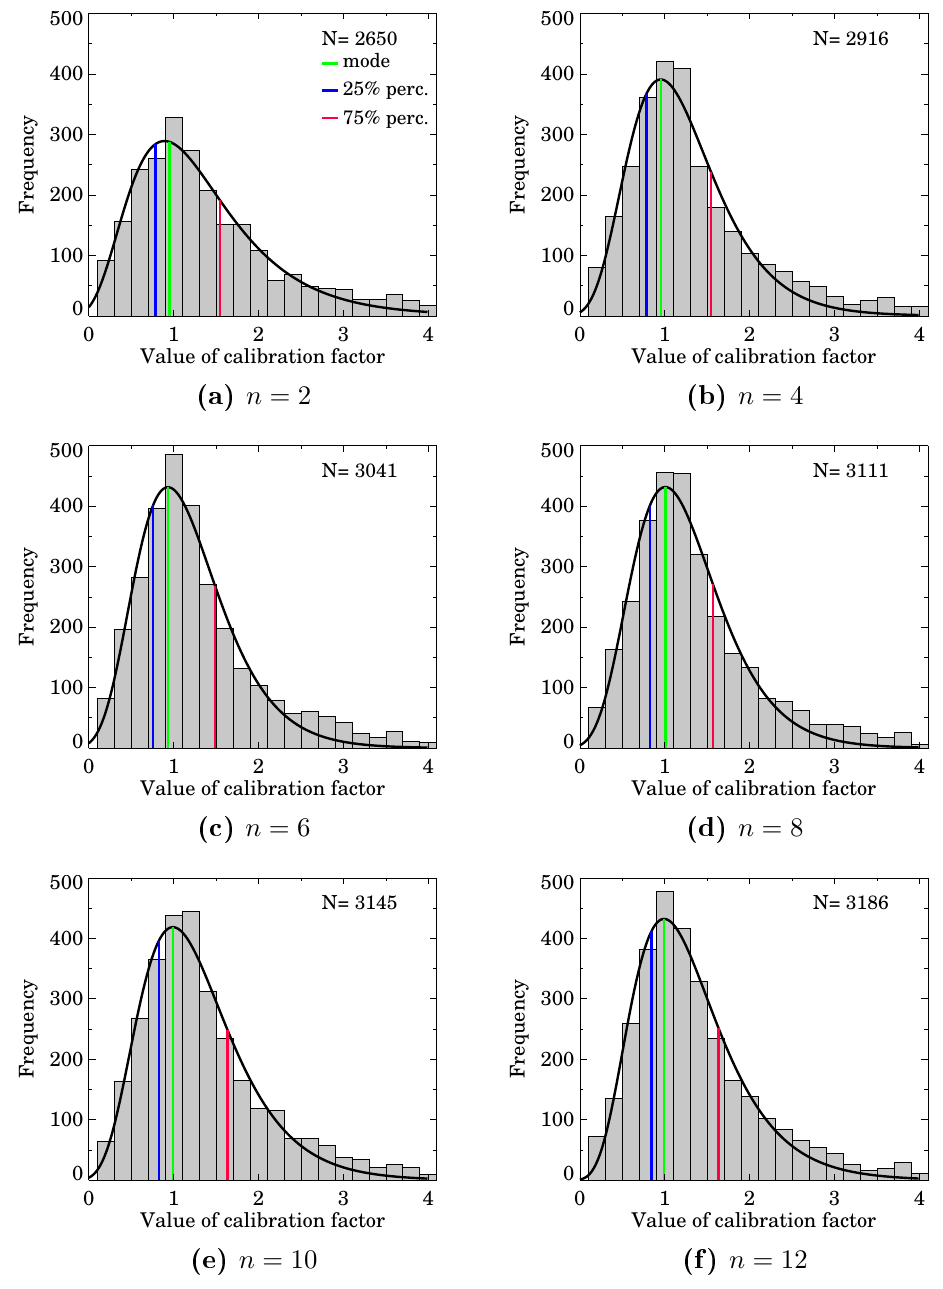
Figure 6. Distributions of the correction factor C − 1 calculated using synthetic data with realistic precipitation patterns and fitted logarithmic 3 normal distribution functions for six values of n . The total amount of considered time steps is indicated by N . The mode, 25th and 75th percentile of the fitted distributions are shown in green, blue and red,